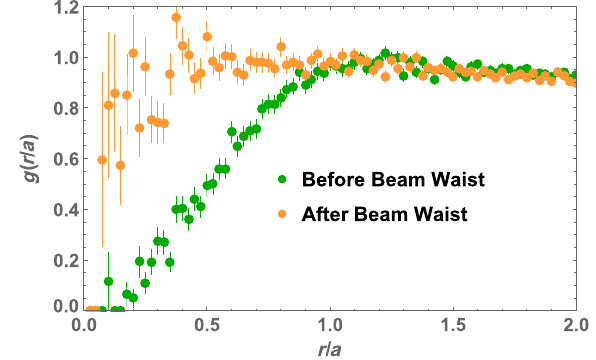
FIG. 12. Radial distribution function comparison between of the NCRF beam line with an MTE of 0 meVand an initial density of 10 17 m − 3 before and after the beam waist. For comparison, the distances were normalized by the average interparticle distance, a , and the radial distribution functions, g ð r=a Þ , were normalized such that g ð r=a ¼ 1 . 25 Þ ¼ 1 .